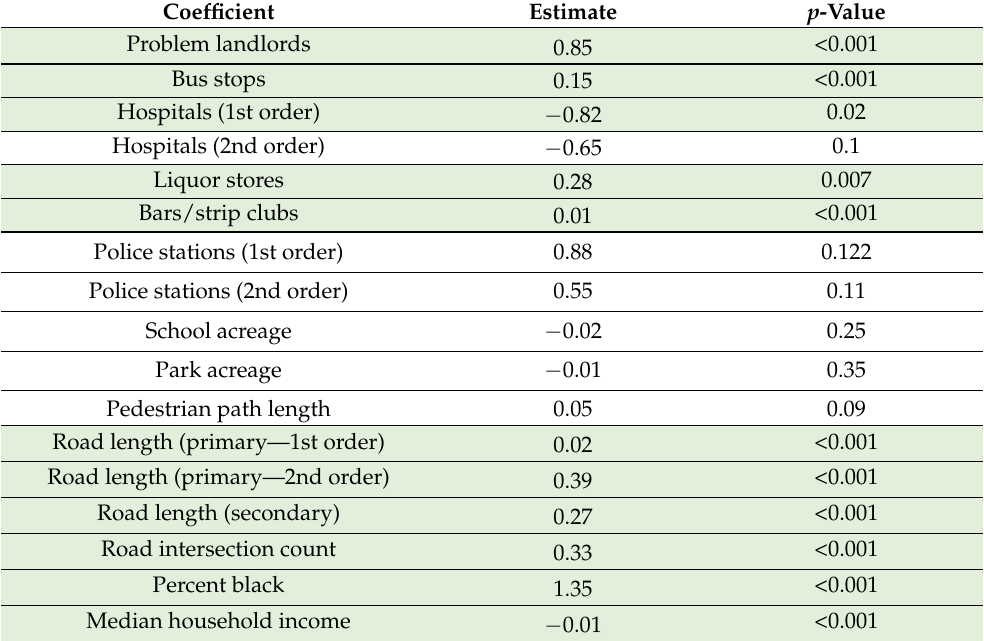
Table 2. Coefficient estimates and p -values for the logistic regression seeking to classify cells as high or low prostitution. The entries in light green are significant at the 0.05 level. Coefficient Estimate p -Value Problem